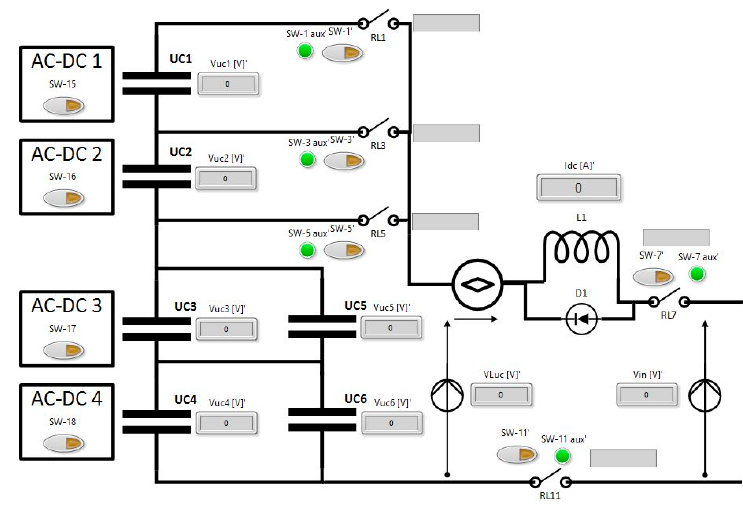
Figure 2. Block scheme of the charging station.